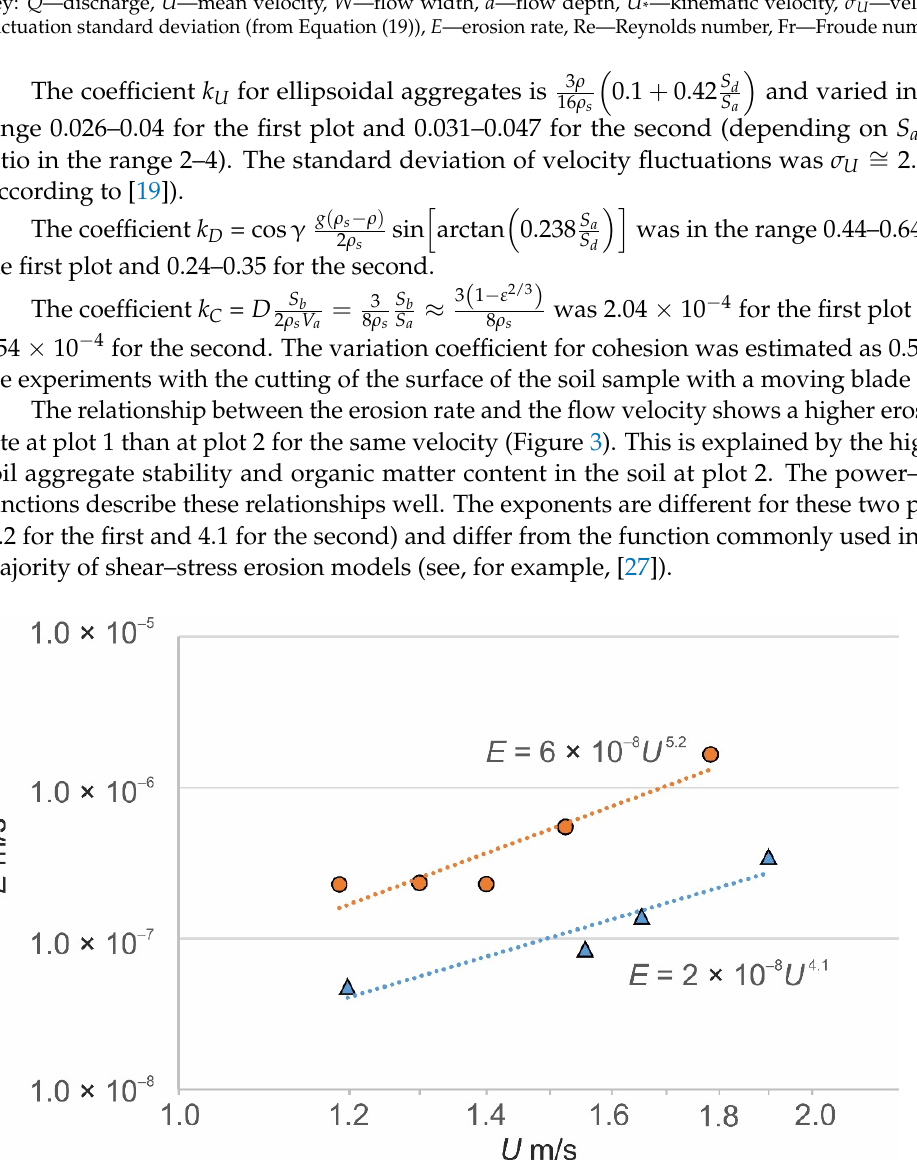
Figure 3. The relationship between flow velocity U and erosion rate E for plot 1 (circles) and plot 2 (triangles) in the experiments in Ballantrae Hill